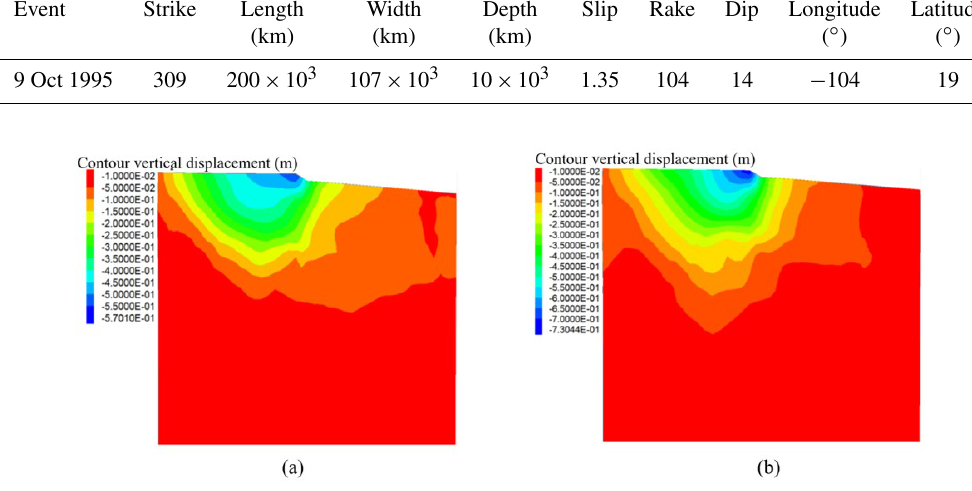
Figure 20. Permanent vertical displacements for scenarios (a) 4 and (b) 5.